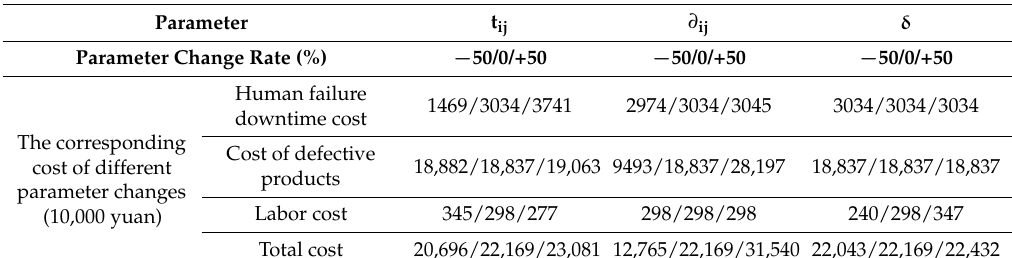
Table 15. The influence of parameter changes on the optimal solution of the system (sensitivity analysis).